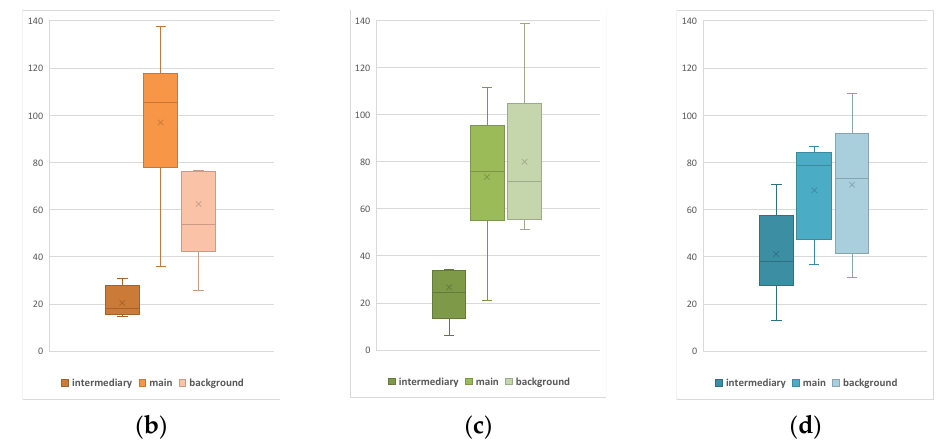
Figure 18. Angle values of color triangles in Sections I ( a ), II ( b ), III ( c ), and IV ( d ); within bars, lines show medians and the “x” symbols show the mean; whiskers denote minimum and maximum values.